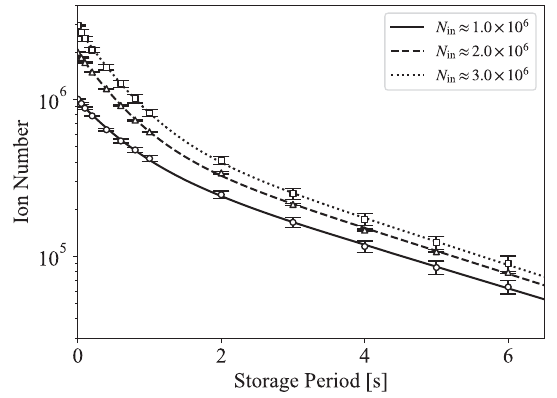
FIG. 4. Long-term decay of stored ions at the operating point ð μ σ Þ ¼ ð 50 . 0 ° ; 26 . 4 ° Þ . The initial ion number N 0 ⊥ ; 0 k to about 1 × 10 6 (solid), 2 × 10 6 (dashed), and 3 × 10 6 (dotted). The three curves are obtained from the fitting function in Eq. (3) with the decay constants listed in Table